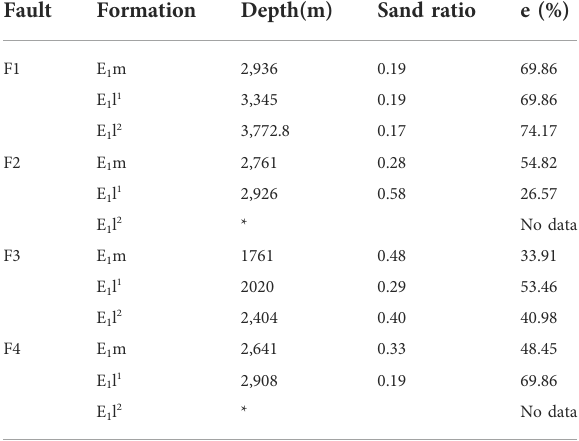
TABLE 3 Lithology juxtapositional sealing rate (e) of main faults in the Lishui West